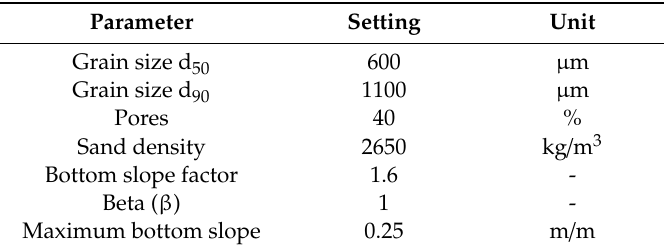
Table A1. Basic morphological model